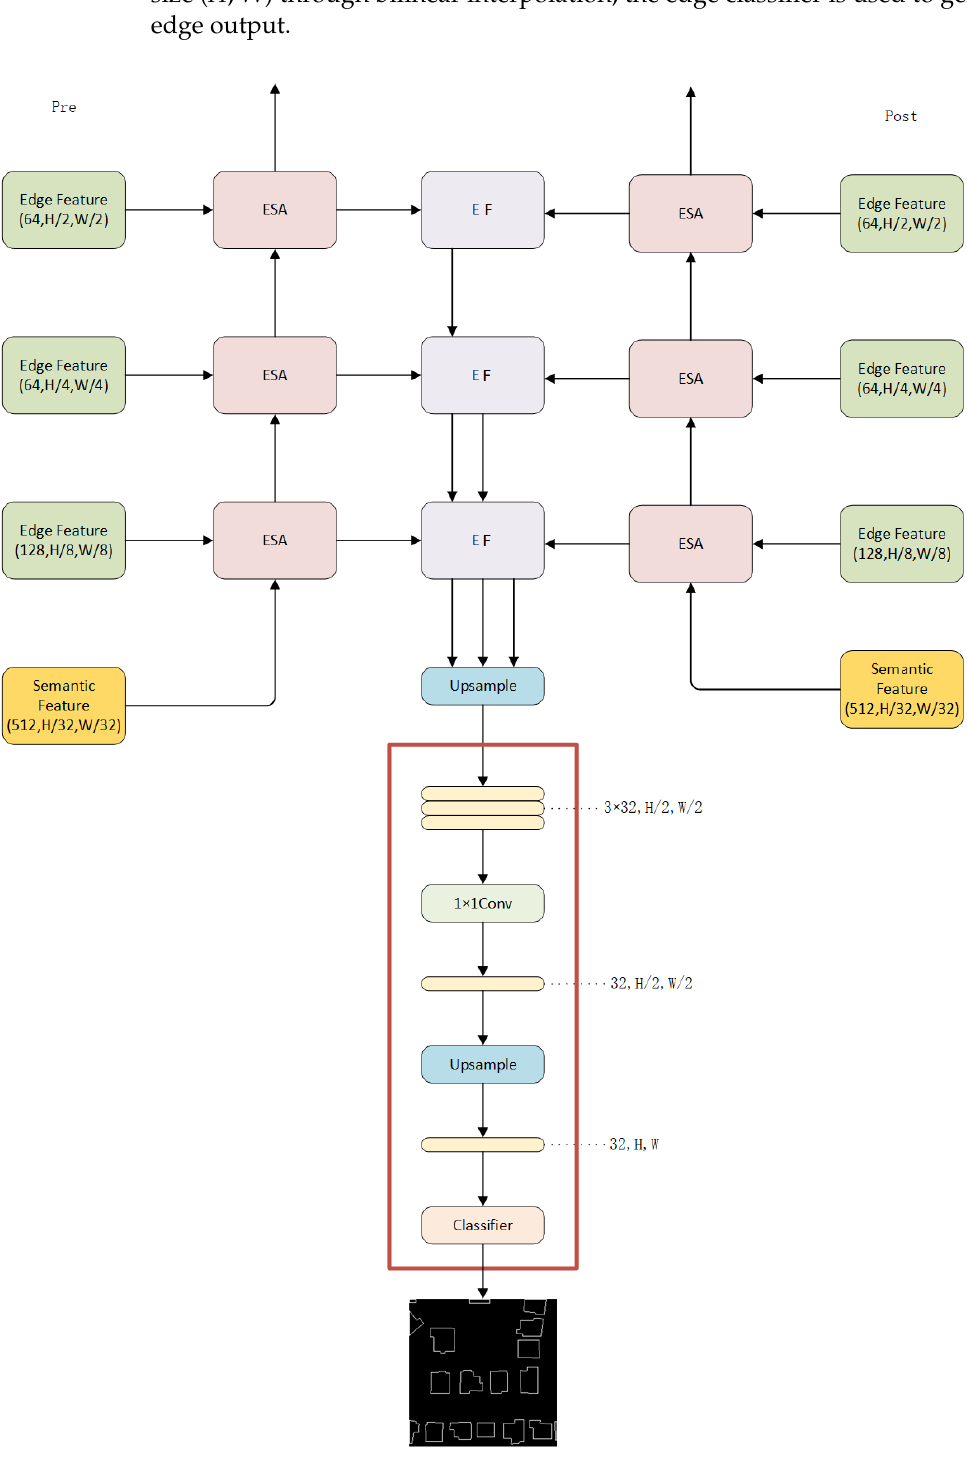
Figure 7. The details of the edge detection branch. The red box is the edge multiscale feature fusion modules.